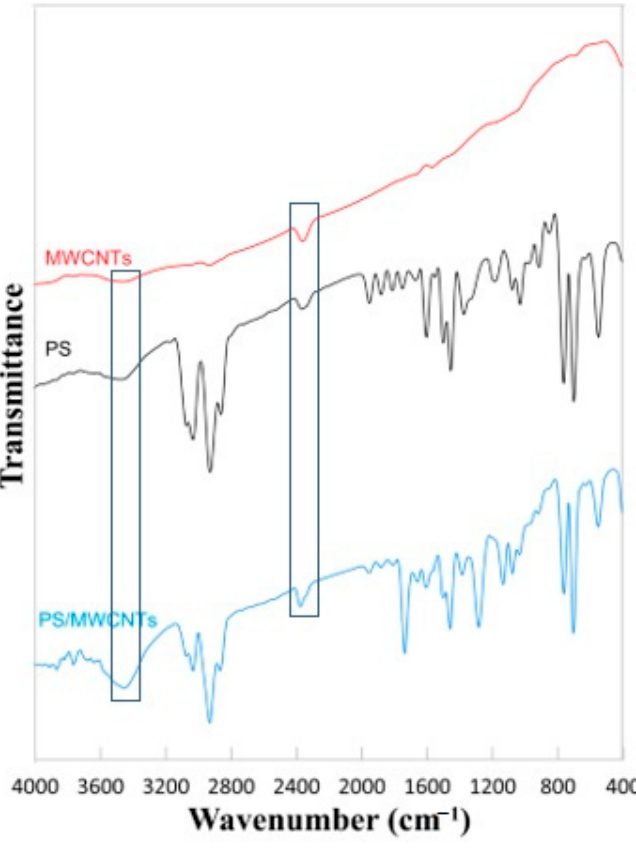
Figure 3. FTIR spectra of MWCNTs and PS neat and PS/MWCNTs composite and nanofibrous membranes.